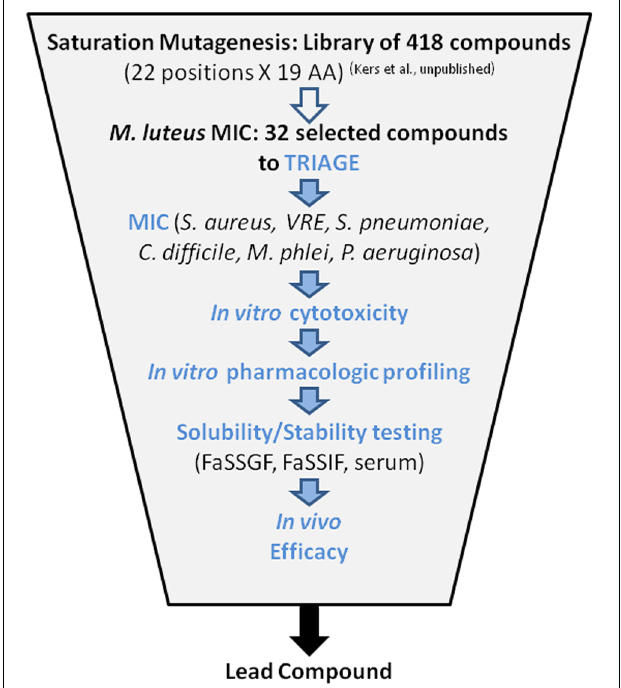
FIGURE 2 | Triage